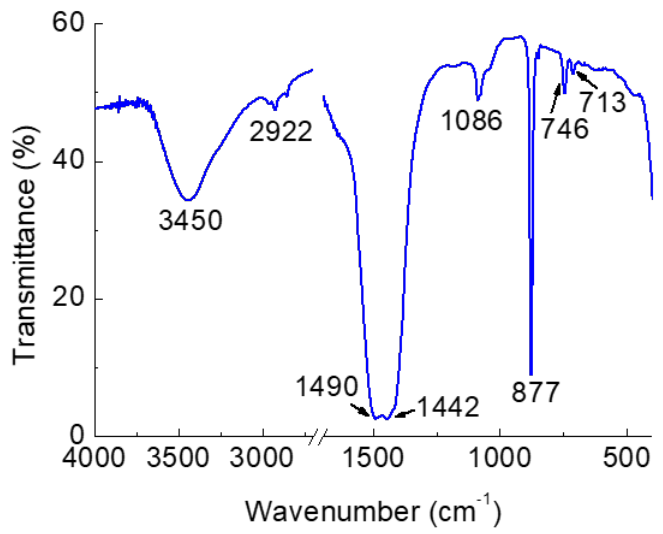
Figure 5. FTIR spectrum of the sample W:EG 1:5, 30 min.